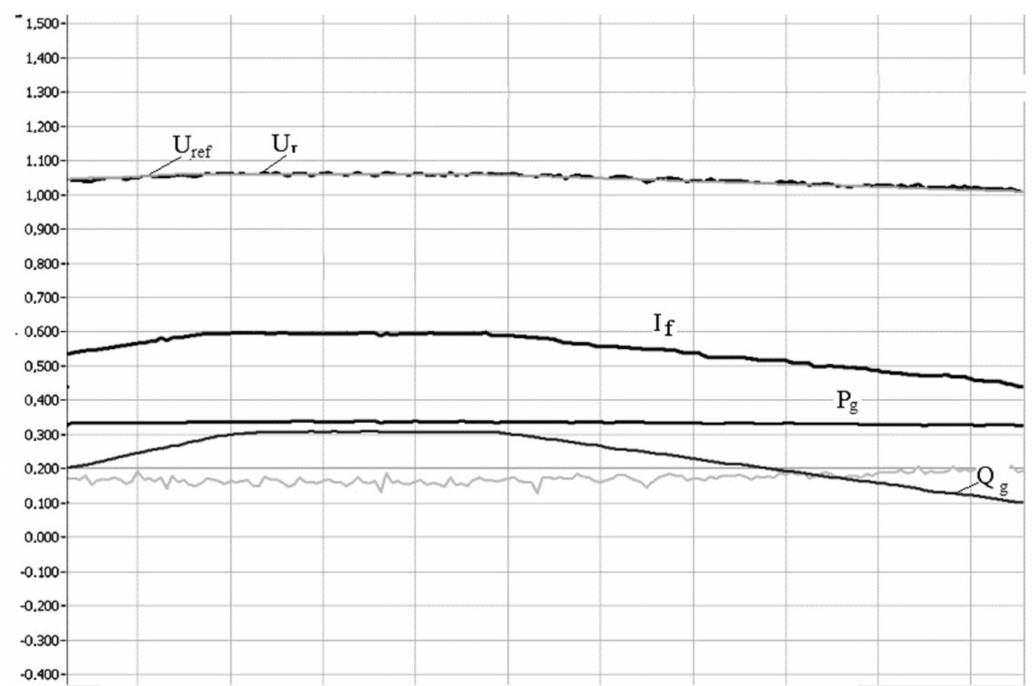
Figure 5. The oscillogram for the mode of the generator’s reactive power regulation by changing the generator’s voltage setting (the time scale is 2